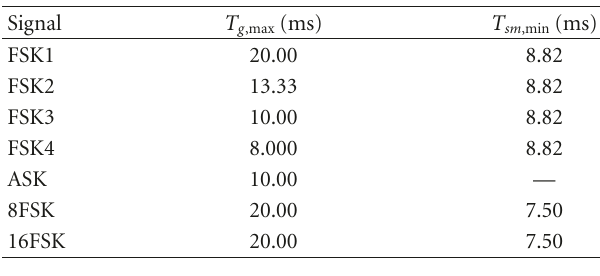
Table 1: Limit of kernel parameters. (Obtained mathematically from signal parameters.)